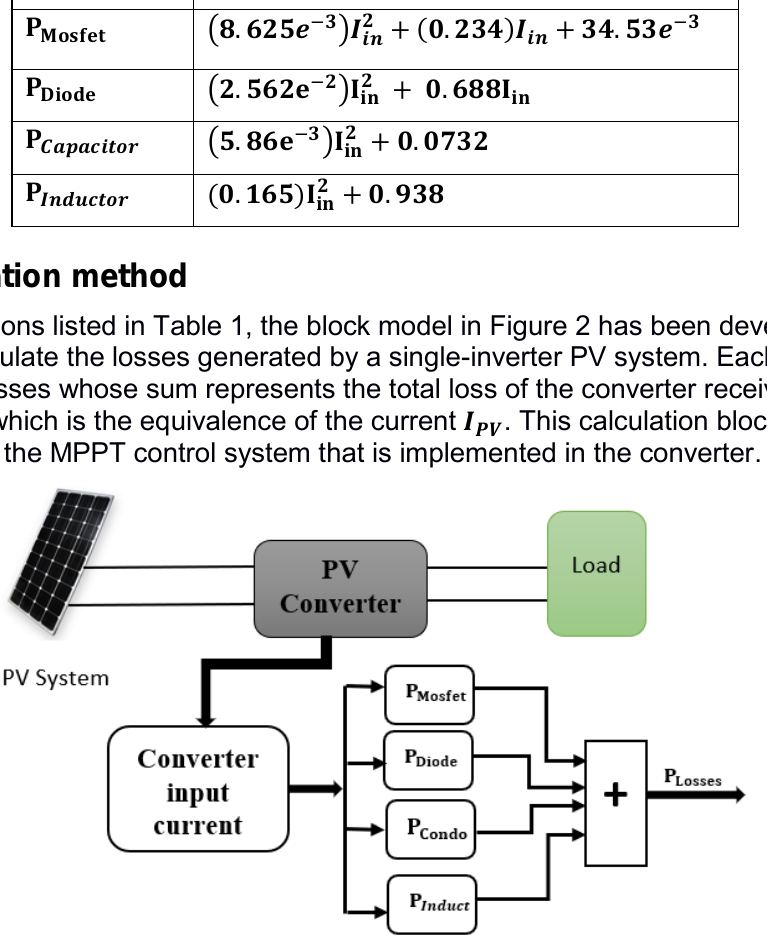
Figure 2 : Total loss calculation blocks of a DC-DC converter in a PV